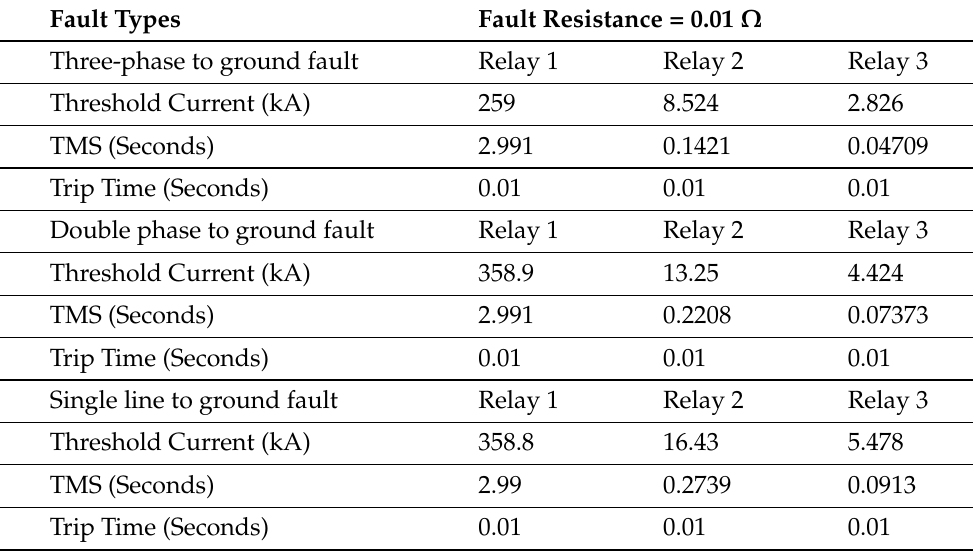
Table 4. Threshold current at fault resistance of 0.01 Ω .